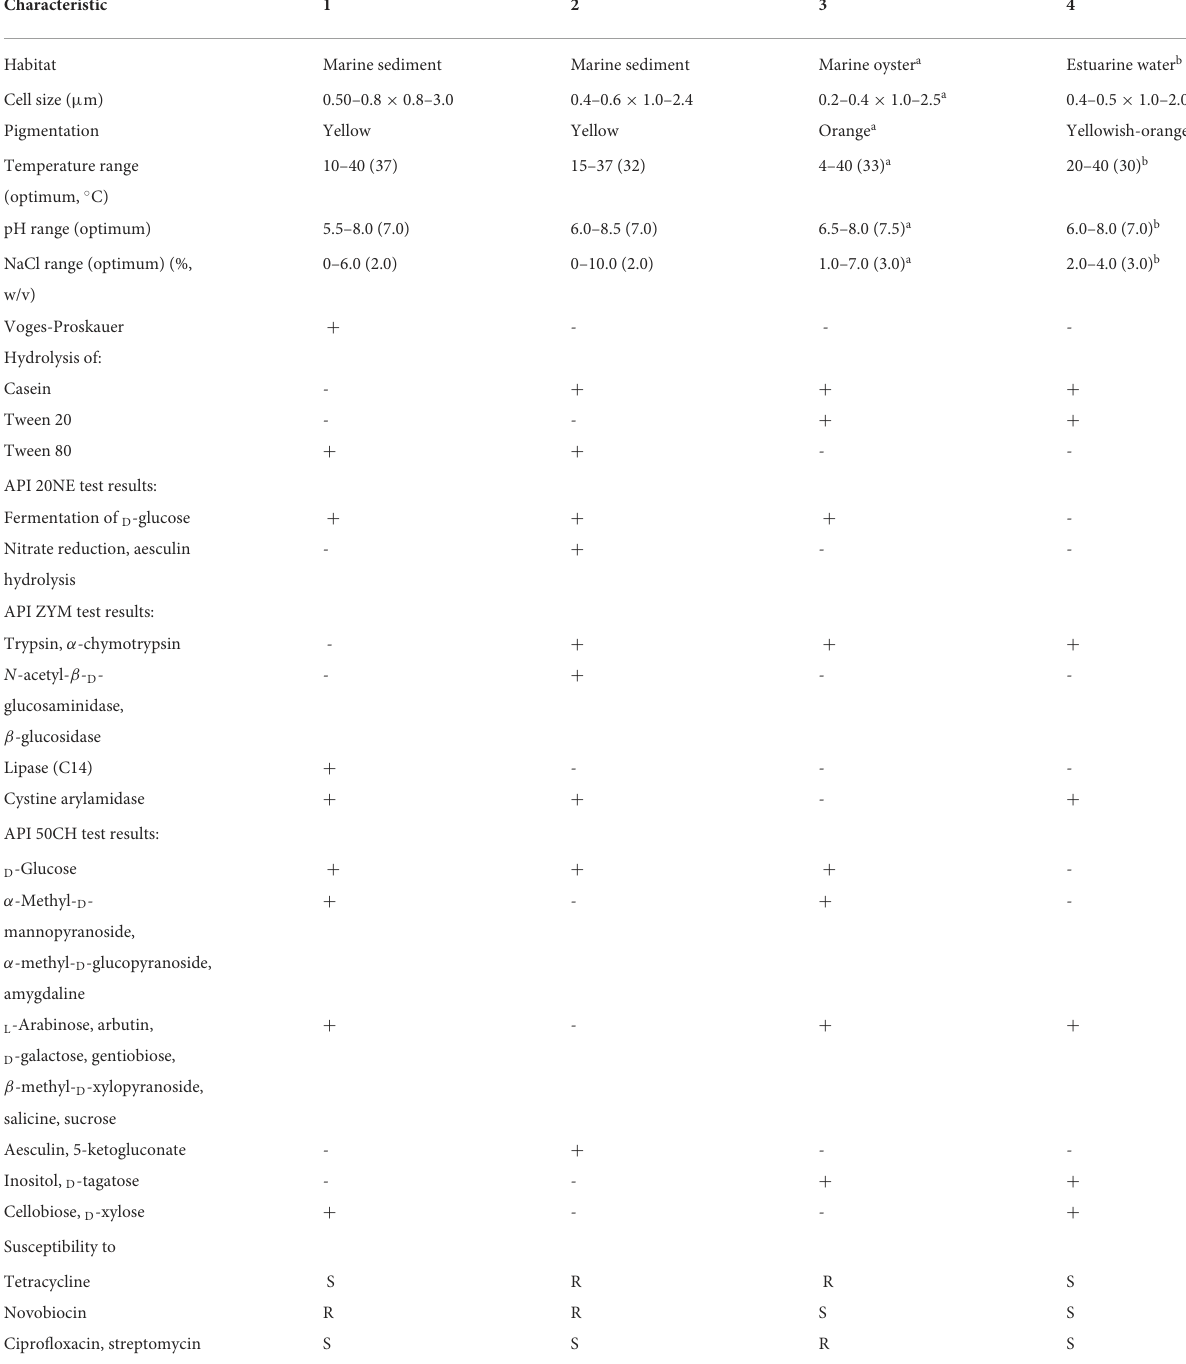
TABLE 1 Differential characteristics of strain NBU2968 T , strain NBU2984 T , and related type strains of the genus Hanstruepera . Characteristic Habitat